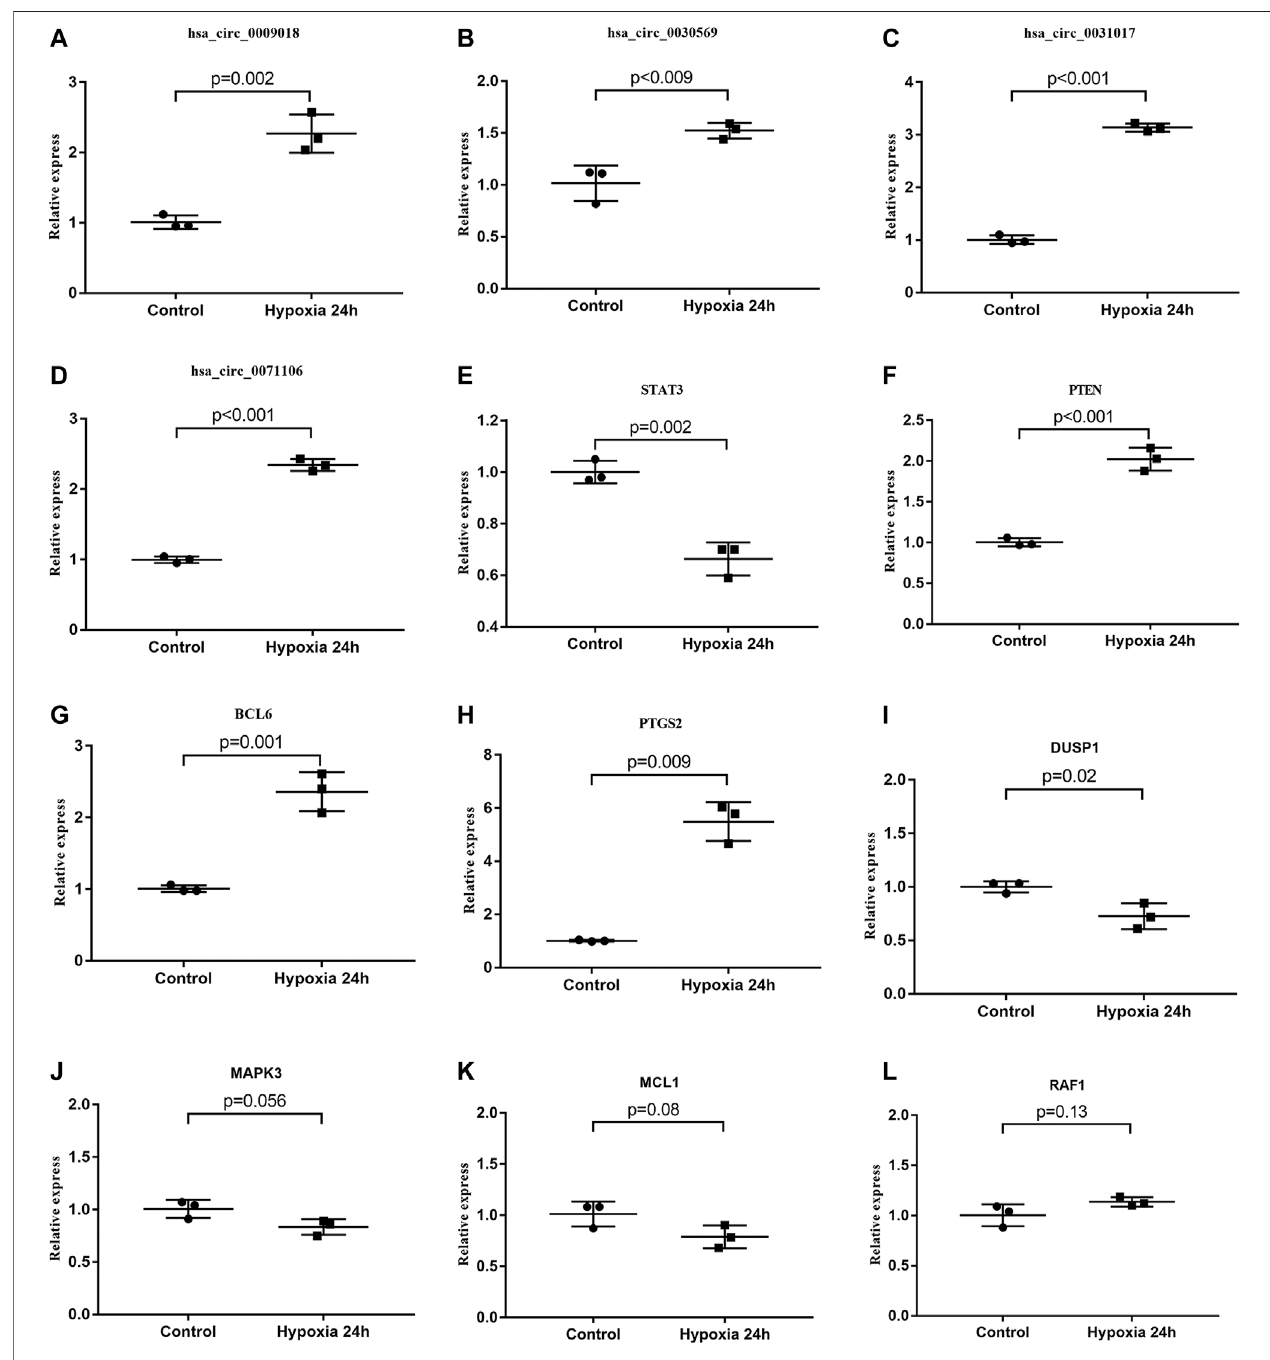
FIGURE 8 | qRT-PCR identi fi cation of circRNAs and hub genes. (A – D) The expression levels of circRNAs in hypoxia treated AC16 and normal controls. (E – L) Comparison of hub gene expression between hypoxia treated AC16 cells and normal controls. Among the detected circRNA and hub genes, hsa_circ_0031017, hsa_circ_0030569, hsa_circ_0009018, BCL6, PTGS2 and PTEN expression results were consistent with the difference